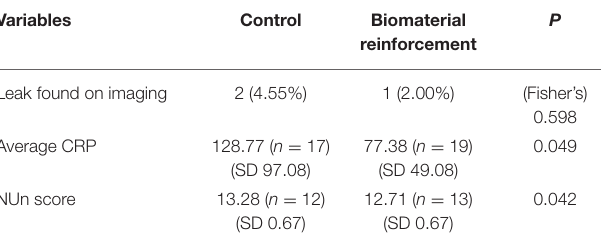
TABLE 3 | Comparison of results related to anastomotic